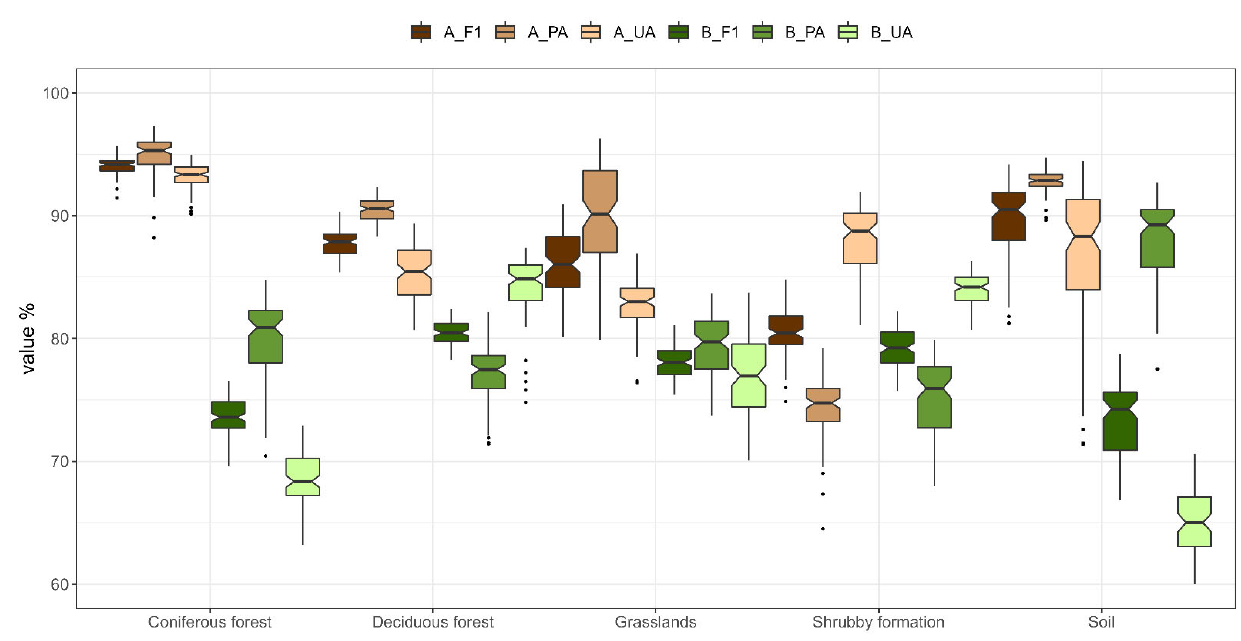
Figure 5. The result for the RF classifier for MNF+CHM+INDICES data set for AISA in A and B area. F1-score; PA-Producer Accuracy; UA-User Accuracy; 100 iterations.